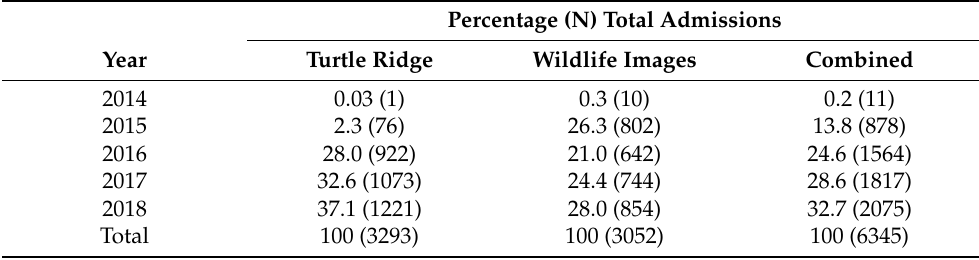
Table 2. Ten most frequently admitted avian species at each wildlife center, regardless of presumed cause; Turtle Ridge, Salem, and Wildlife Images, Grants Pass, Oregon. Turtle Ridge Wildlife Images Species